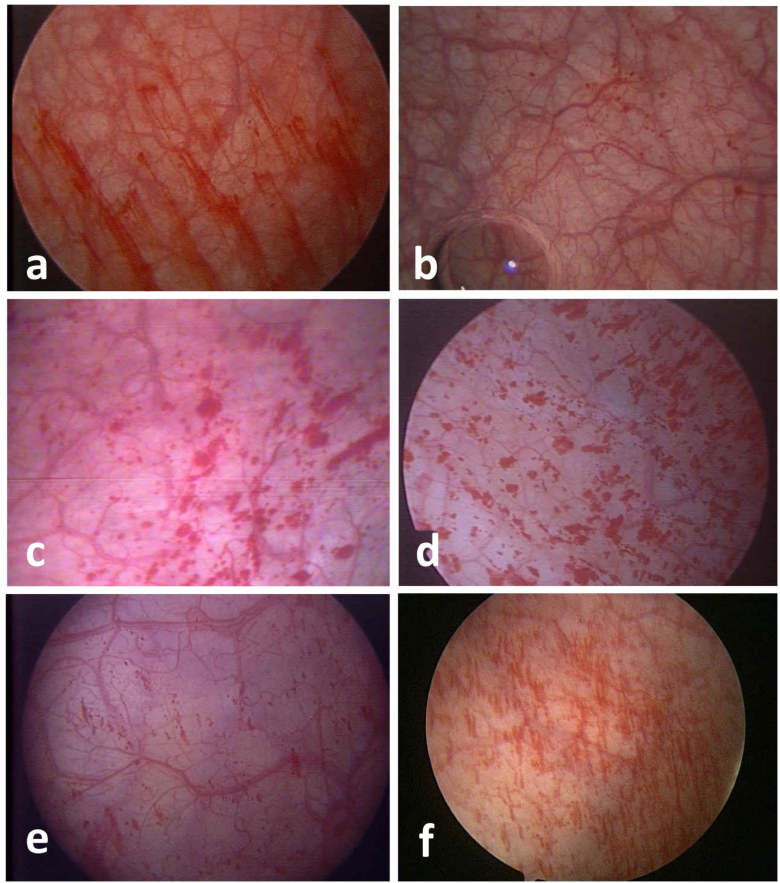
Figure 1. Different changes of glomerulation grades in three patients before and after intravesical HA treatment in cystoscopies. ( a ) A 63-year-old woman with Grade 2 glomerulation of the